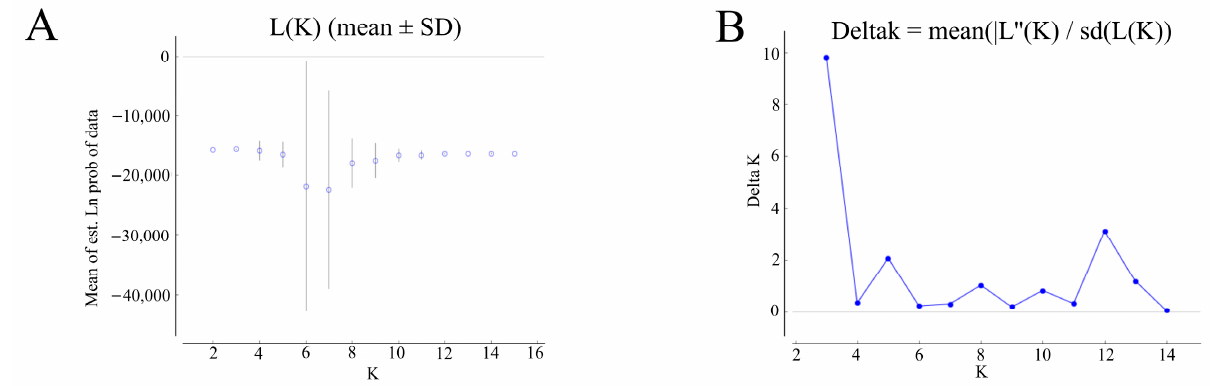
Figure 6. Figure 6. A structure analysis of 140 oil-tea camellia samples. ( A ): Estimated LnP(D) of K from 2 to 16. ( B ): Δ K according to the rate of change of LnP(D) between successive K. ( C ): Genetic structure of oil-tea camellia population.